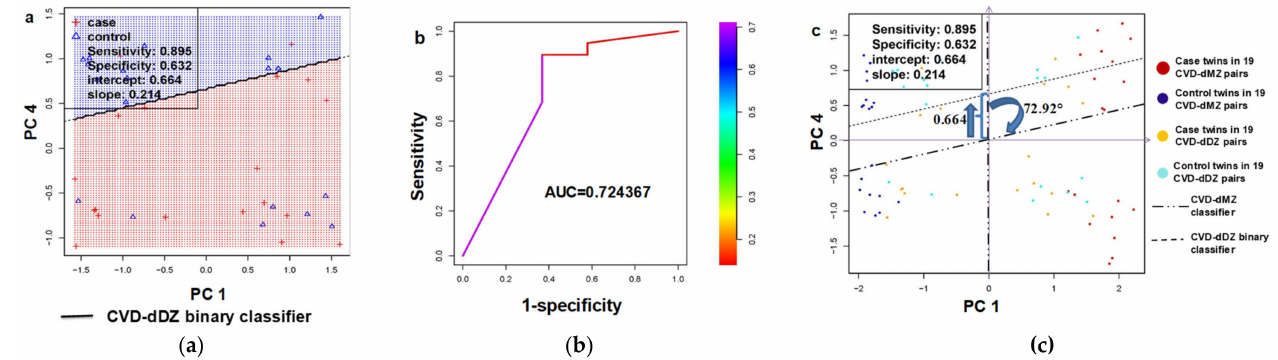
Figure 2. Visualization of the binary linear classifier among 19 dizygotic twin pairs (DZ) discordant for cardiovascu- lar death (CVD-dDZ) generated with the 102 candidate DhMRs identified from monozygotic twin pairs (MZ) discor- dant for cardiovascular death (CVD-dMZ) using 1000 times simulation. ( a ) A principal component analysis of the 102 DhMRs generated principal component 1 (PC1) and principal component 4 (PC4). The points in the area below the binary linear classifier are case twins while points above the classifier are control twins. Binary linear classifier √ √ 3 PC 4 = 0.664 0.214 × 3 PC 1 ; ( b ) receiver operating characteristic (ROC) curve and the area under the curve (AUC) using the binary linear classifier for the CVD-dDZ; ( c ) graph-based 2D topology of genetic influences on the binary linear classifier by comparison between MZ and DZ pairs. Two blues arrows show the two-step topological changes (i.e., 2-D transformation) of the MZ classifier (i.e., the vertical line across the origin) to the DZ binary classifier line with a slope of 0.214. The first step is indicated with a clockwise half-circle arrow representing the clockwise rotation of the MZ classifier at the origin by 72.92 ◦ . The second step is indicated with an upward arrow in blue representing an upward movement of the rotated MZ classifier along the vertical axis by 0.664